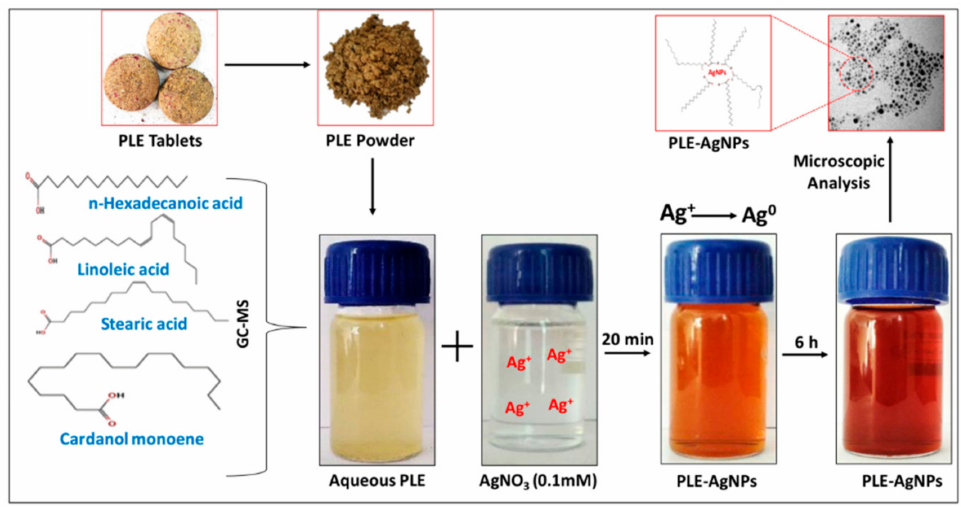
Figure 2. Schematic representation of LIV-AgNPs